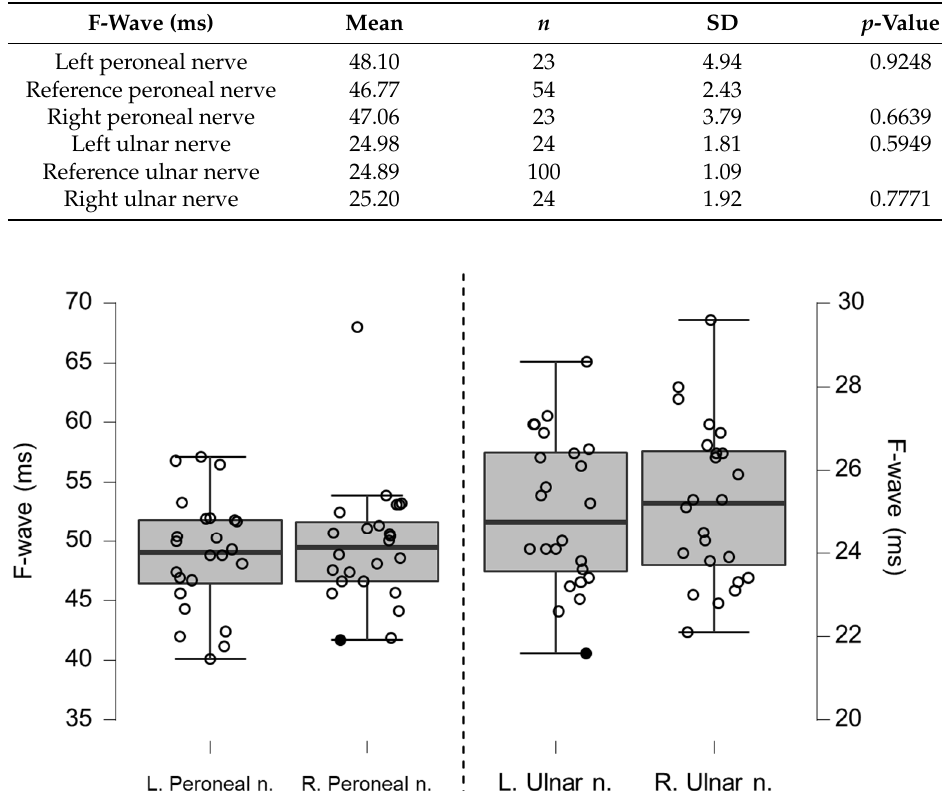
Figure 7. Box-plots for motor neurography F-wave latencies. Filled circles represent values ≥ two standard deviations outside reference values. Table 6. Motor neurography amplitudes for left and right peroneal and ulnar nerve. ** and *** indi- cate statistically significant differences to reference material with p -values corresponding to Bonfer- roni corrected 0.01, and 0.001, respectively.